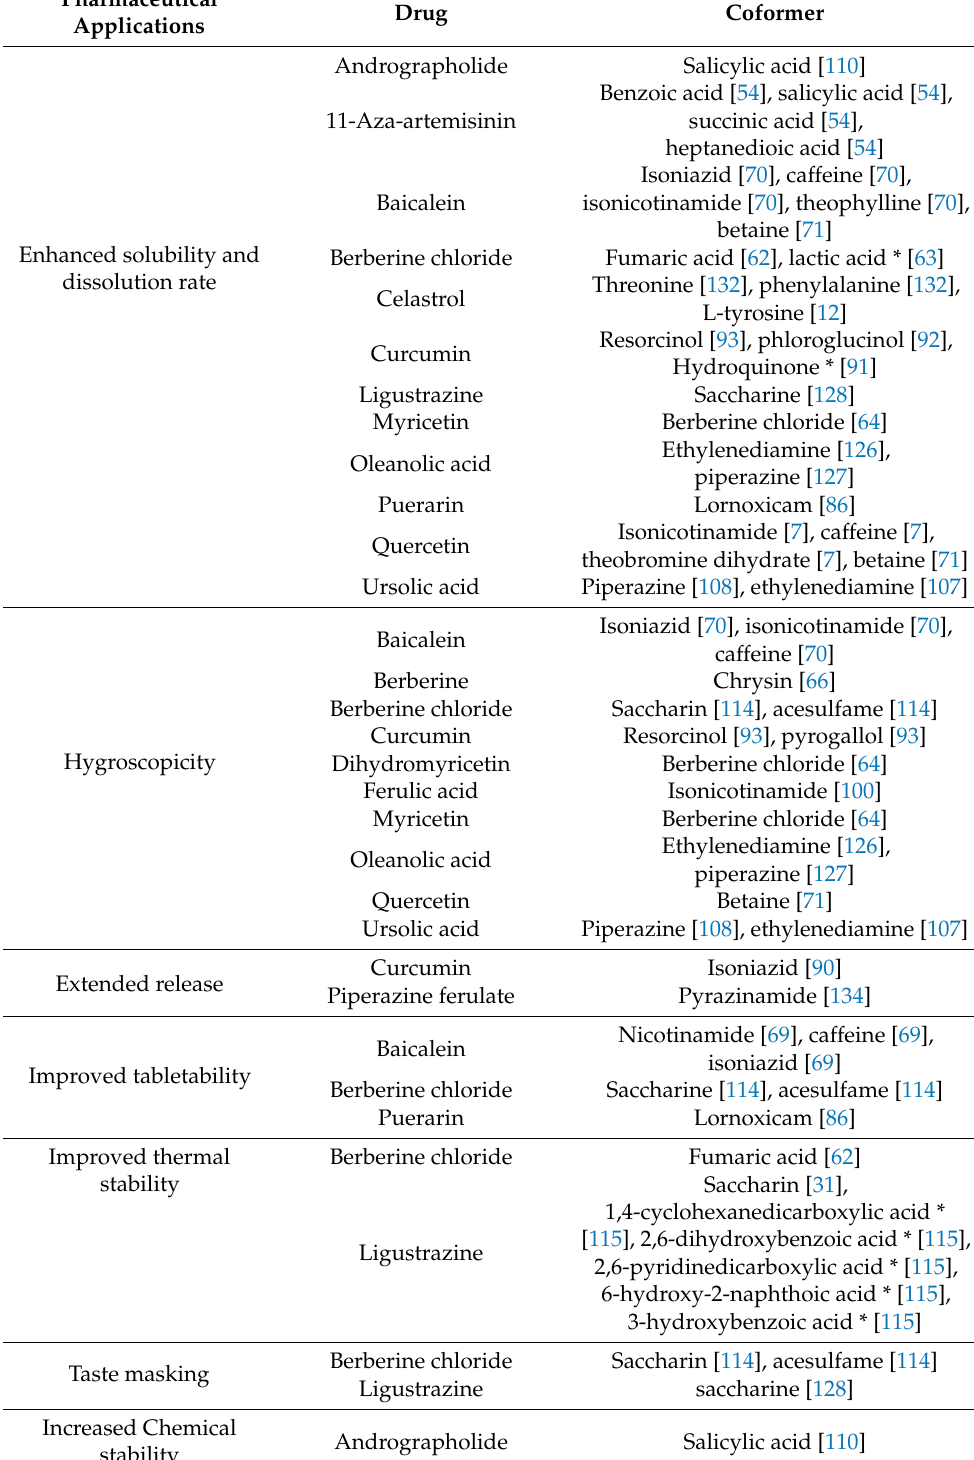
Table 5. Physicochemical properties modified through pharmaceutical